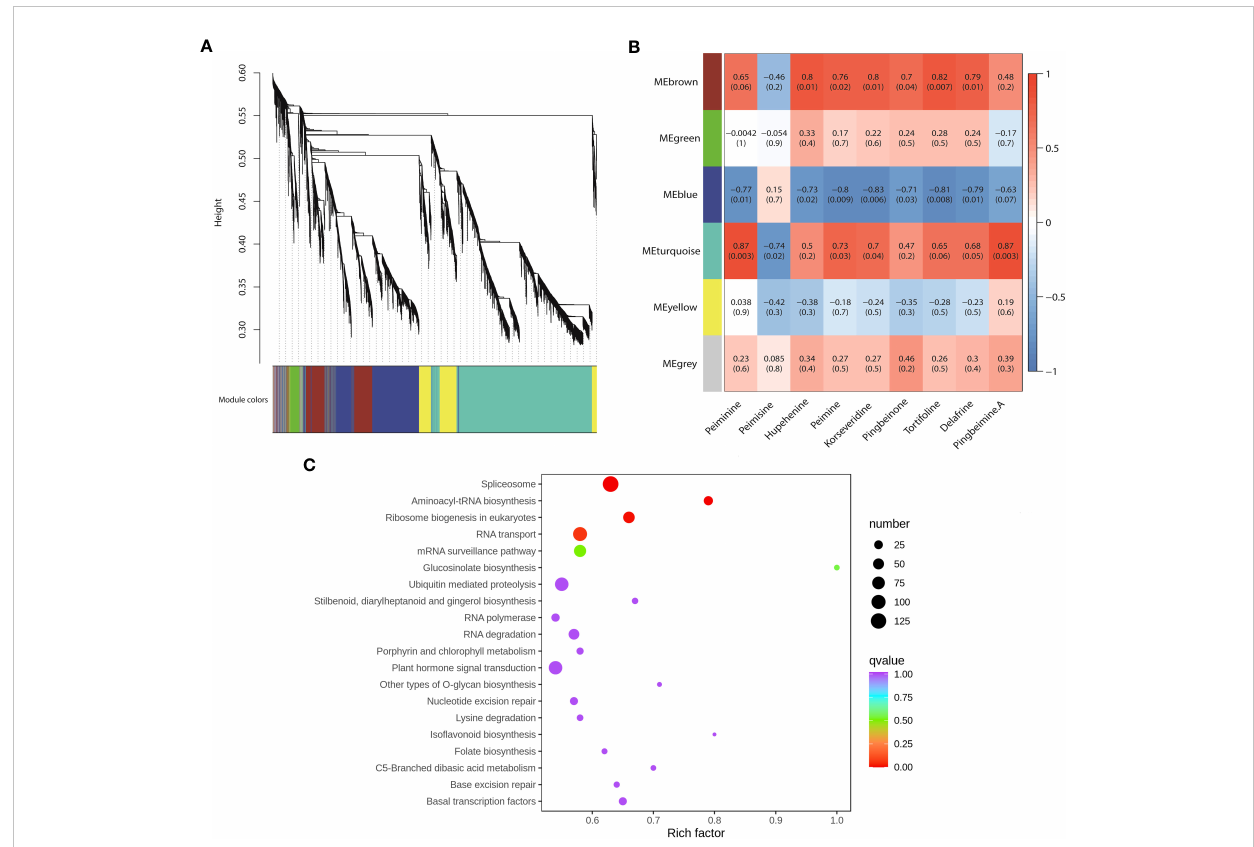
FIGURE 6 WGCNA of DEGs related to steroidal alkaloids. (A) . Cluster dendrogram. (B) . Correlations between modules and steroidal alkaloids. The number represents the correlation coef fi cient and p value. Blue indicates low correlation, and red indicates high correlation. (C) . KEGG analysis of 4,268 genes in the MEturquoise